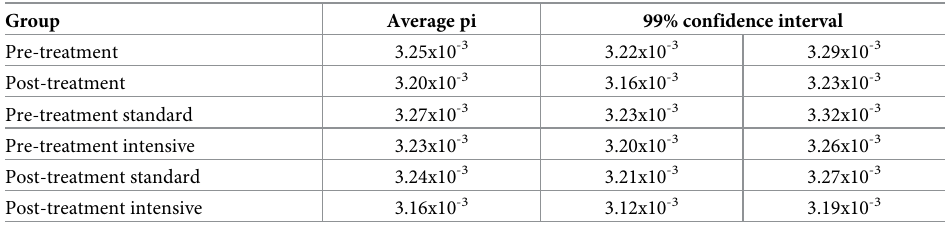
Table 1. Genome-wide average nucleotide diversity